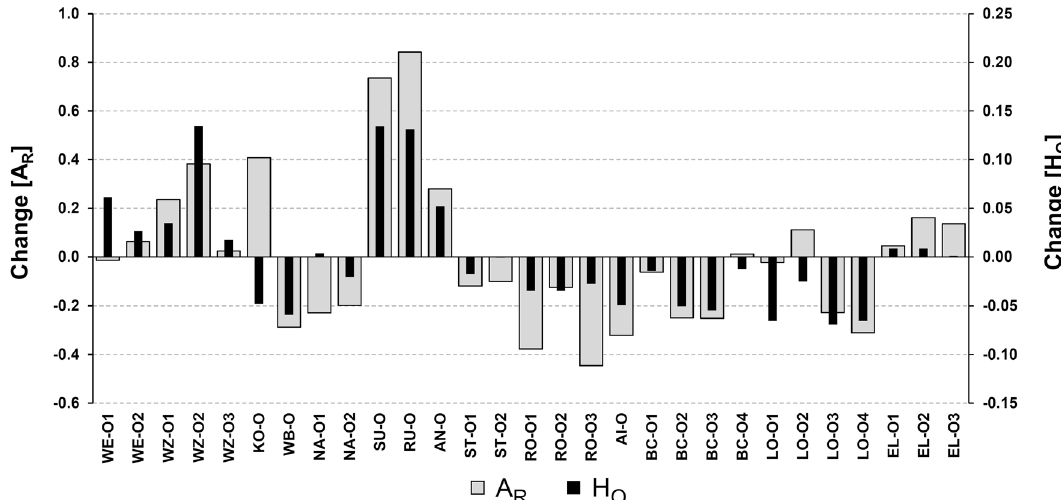
Figure 2. Change of allelic richness (A R ) and observed heterozygosity (H O ) of 29 captive bred Margaritifera margaritifera cohorts compared to corresponding source